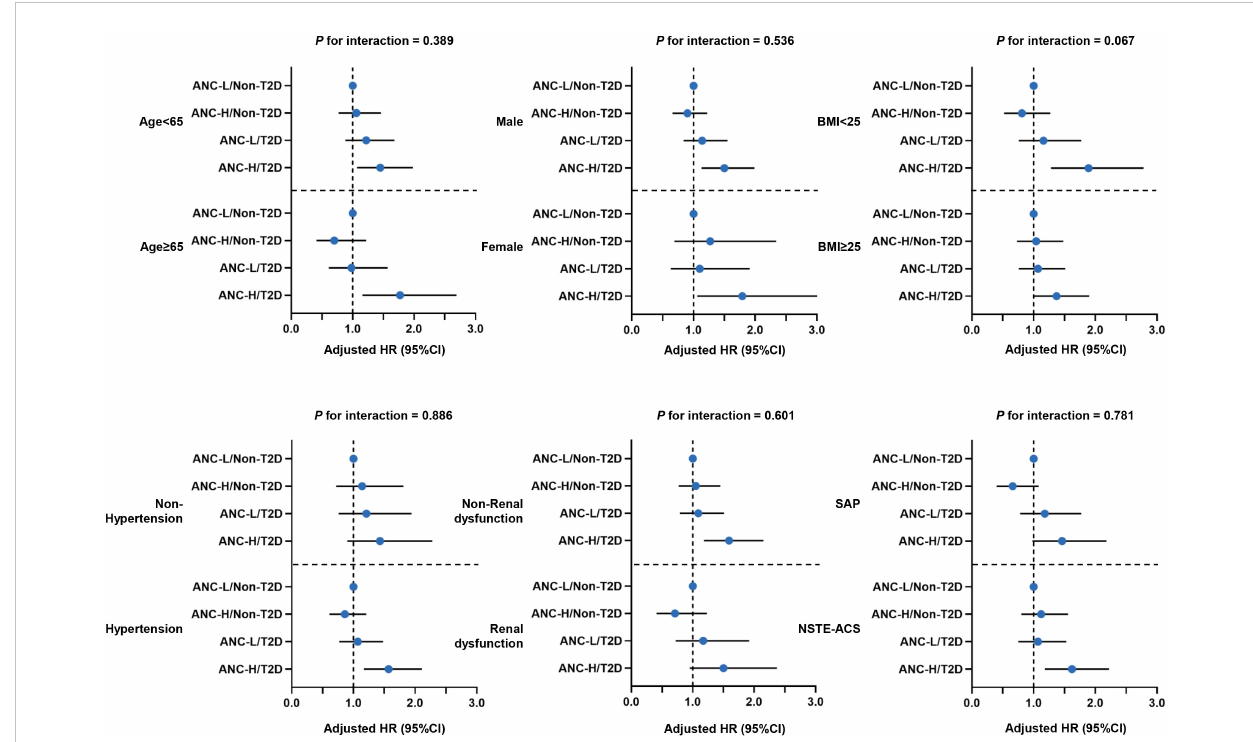
FIGURE 4 Forest plot of MACCE risk according to various subgroups. Model adjusted for age, male sex, BMI, hypertension, dyslipidemia, smoking history, previous MI, previous PCI/CABG, previous stroke, NSTE-ACS, hsCRP, eGFR, LVEF, LM/three-vessel disease, CTO lesions, number of treated vessels, and SYNTAX score. Abbreviations as in Figure